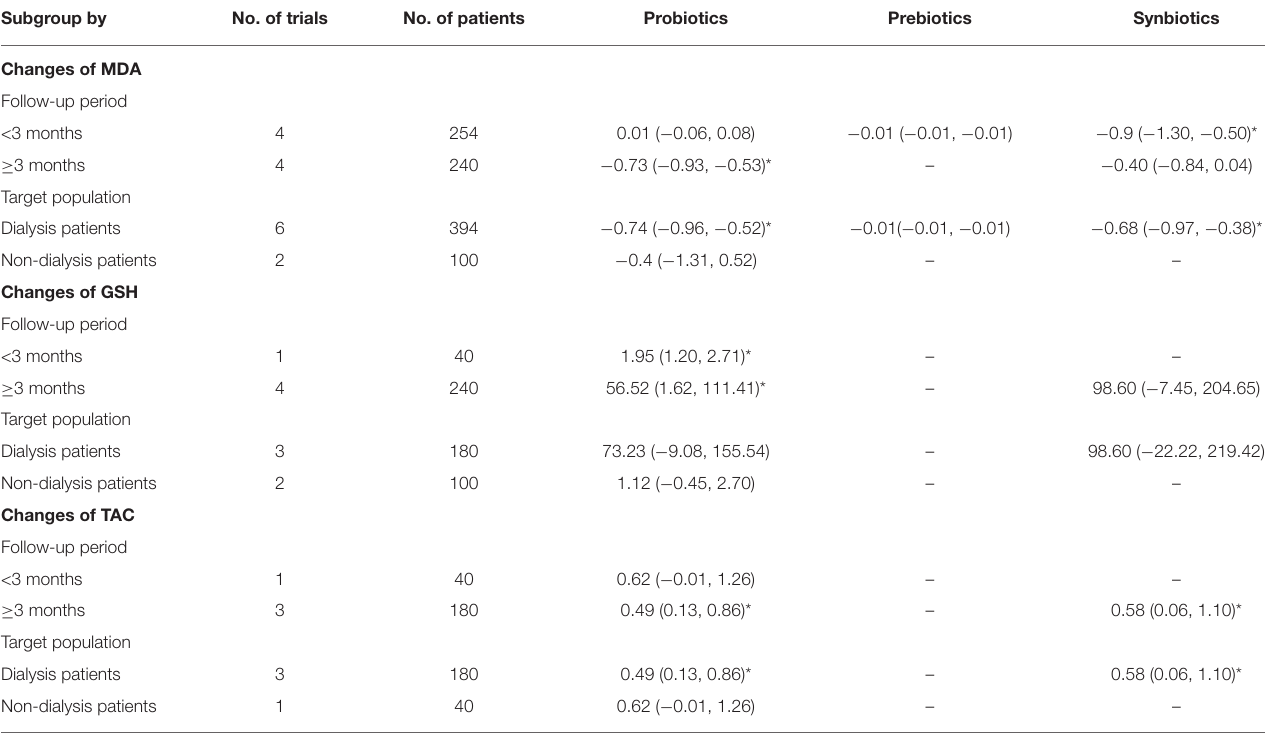
TABLE 5 | Subgroup analysis of oxidative stress. Subgroup by No. of trials No. of patients